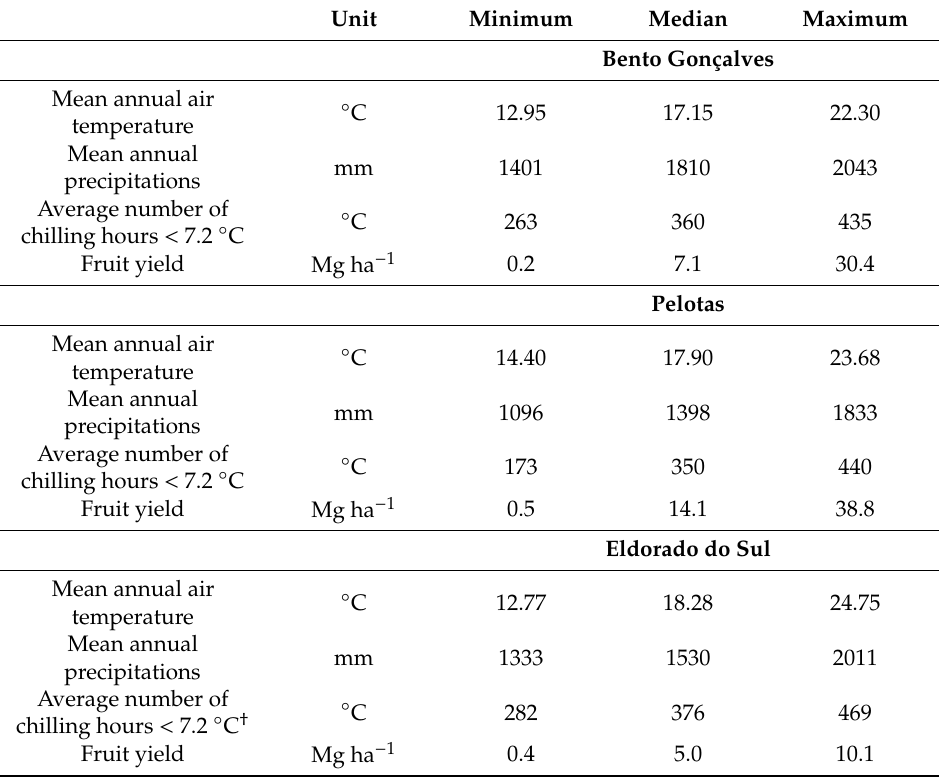
Table 2. Synthetic meteorological variables and fruit yield in the peach orchard data set of Rio Grande do Sul, Brazil